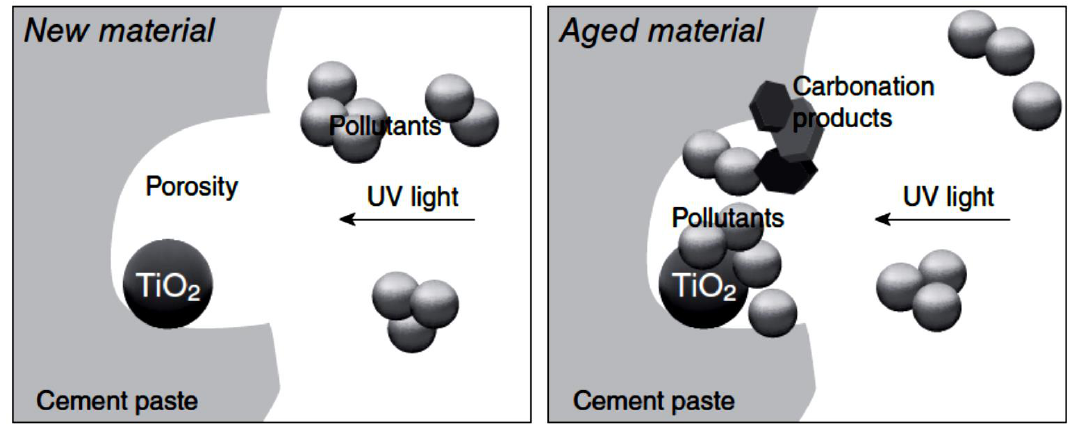
Figure 13. E ff ect of aging on the possible shielding e ff ect of photocatalytic cementitious materials Figure 13. Effect of aging on the possible shielding effect of photocatalytic cementitious materials [21].